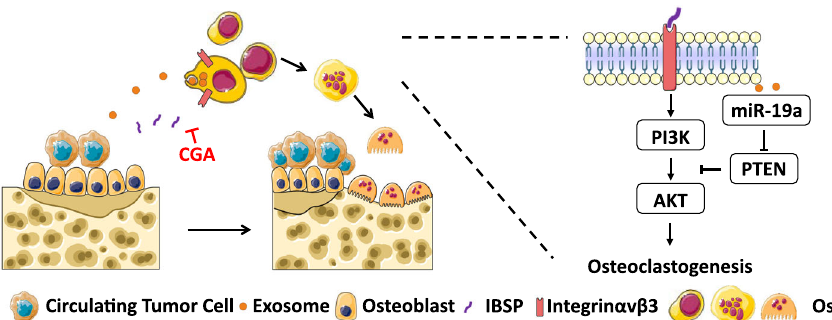
Fig. 7 CGA blocks cooperative function of miR-19a and IBSP in ER + BCBM. a The mice were treated with 2 µ g exosomes prepared from MCF7BoM2 and 0.5 µ g recombinant IBSP by injecting them into the tibias every two days. The exosomes from MCF7BoM2/miR-19aKO and PBS were used as controls. After two weeks, the bones were removed, and the TRAP staining of the bones was performed. The OC surface of the bone surface was quanti fi ed by ImageJ and compared by the two-sided student ’ s t -test. p = 0.0181 (PBS + Exo 19aKO vs IBSP + Exo), p = 0.2436 (PBS + Exo 19aKO vs PBS + Exo), p = 0.4594 (PBS + Exo 19aKO vs IBSP + Exo 19aKO ). n = 5 in all groups. b The ratio of OC surface relative to the bone surface was calculated after TRAP staining. p < 0.0001 (MCF7BoM2 vs MCF7BoM2 + CGA, n = 13 vs 8), p = 0.0001 (MCF7BoM2 vs MCF7BoM2 + GW4869, n = 13 vs 5). Representative H&E staining of the same fi eld was shown (left panel) together with the TRAP staining (right panel). Scale bar, 100 µ m. Two-sided student ’ s t -tests were performed. Data are presented as mean values ± SEM. c The legs of tumor-bearing mice were imaged by X-ray, and the bone density was measured by ImageJ. Two-sided student ’ s t -tests were performed. p < 0.0001 (MCF7BoM2 vs MCF7BoM2 + CGA, n = 13 vs 8), p = 0.0002 (MCF7BoM2 vs MCF7BoM2 + GW4869, n = 13 vs 5). Data are presented as mean values ± SEM. d T47D, T47DBoM, and T47D with ectopic expression of miR-19a or/and IBSP were intra-cardially injected into mice. One group of mice injected with T47DBoM also received CGA treatment. The growth of bone metastasis was monitored by IVIS Bioimager, and the Kaplan – Meier analysis and log-rank tests were performed for bone metastasis-free survival. p = 0.000036 (T47D vs T47DBoM); p = 0.0078 (T47D vs T47D/IBSP/miR-19a); p = 0.0003 (T47DBoM vs T47DBoM + CGA). e The legs of tumor-bearing mice were imaged by X-ray, and the bone density was measured by ImageJ. p = 0.0027 (T47D vs T47D/IBSP/miR-19a, n = 4 vs 12); p = 0.0111 (T47D vs T47DBoM, n = 4 vs The ratio of OC surface relative to the bone surface was calculated and compared after TRAP staining. H&E staining of the same fi eld was shown (left panels) together with the TRAP staining (right panels). Scale bar, 100 µ m. p = 0.0028 (T47D vs T47D/IBSP/miR-19a, n = 4 vs12); p = 0.0023 (T47D vs